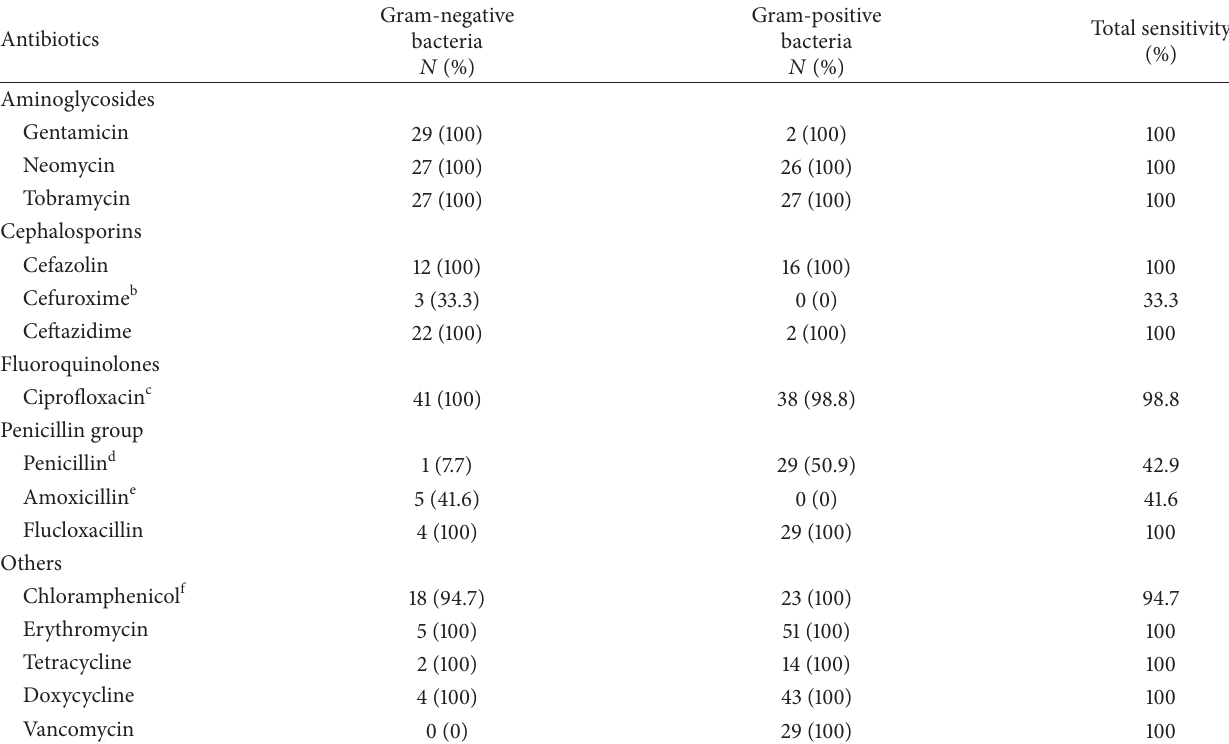
Table 2: Antibiotic susceptibility of bacteria identified in microbial keratitis in Auckland Hospital in New Zealand (2013-2014) a . Antibiotics